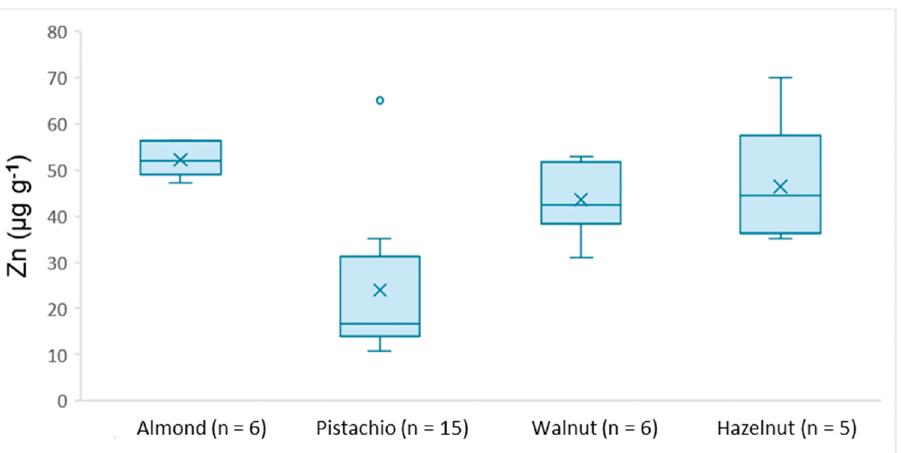
Figure 4. Box and Whisker plot for the concentrations of zinc among different nut species. According to Figure 5, the highest aluminum concentration was determined in al- monds (2.50 µ g g − 1 ) followed by 2.09 µ g g − 1 in walnuts and 1.89 µ g g − 1 in hazelnuts while the lowest average concentration was determined in pistachios (1.36 µ g g − 1 ). The ANOVA showed a statistically significant difference among the samples ( p = 0.02).